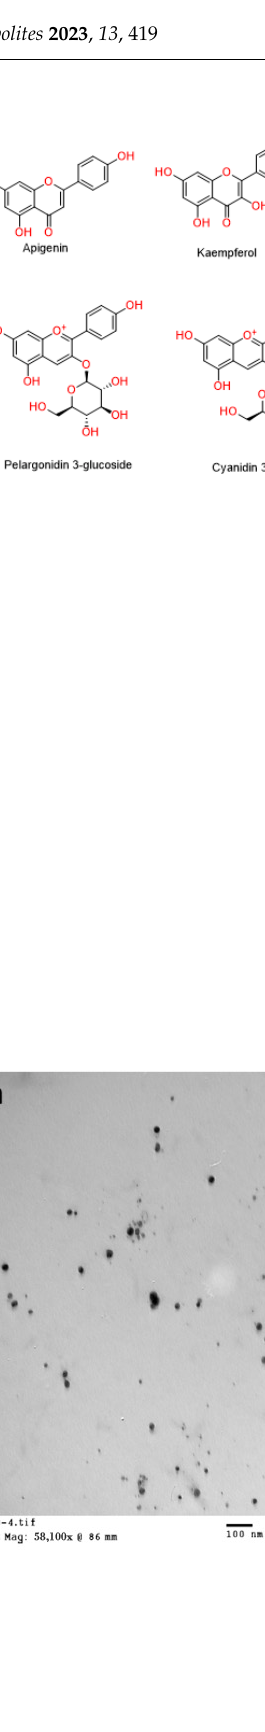
Figure 3. ( a ) TEM and, ( b ) size distribution of BBE ‐ AgNPs (F2).